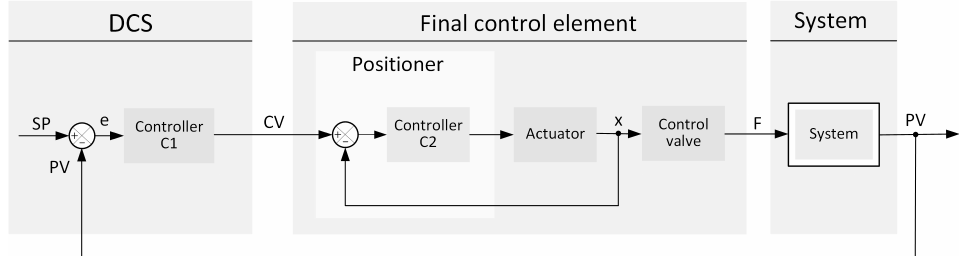
Figure 2. Conceptual block diagram of a classic, single-loop control system. Notations: DCS